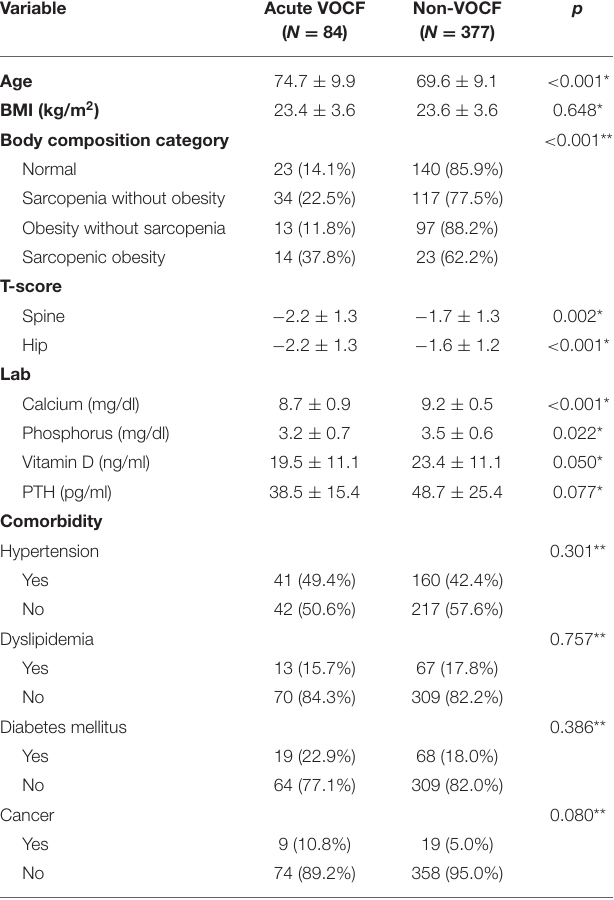
TABLE 3 | Univariate analysis of factors associated with